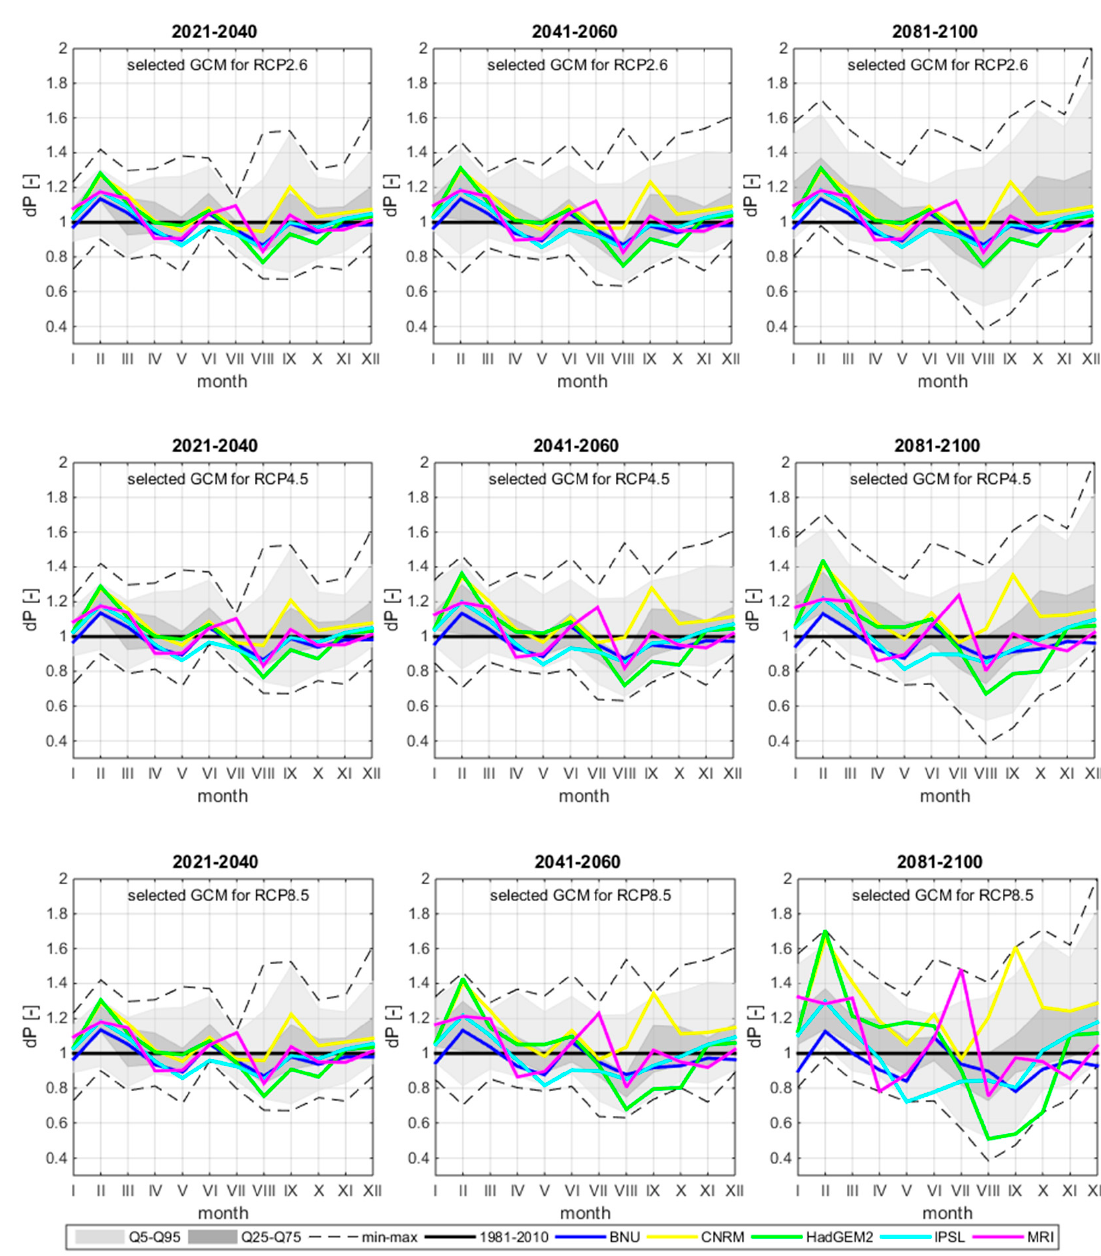
Figure 4. Uncertainty of the estimated monthly precipitation for individual time horizons (columns). The 90% (Q5–Q95) and 50% (Q25–Q75) confidence intervals are calculated for the ensemble of all 34 model outputs. The GCM models from the CMIP5 model for selected RCP emission scenarios (rows) are marked in color.